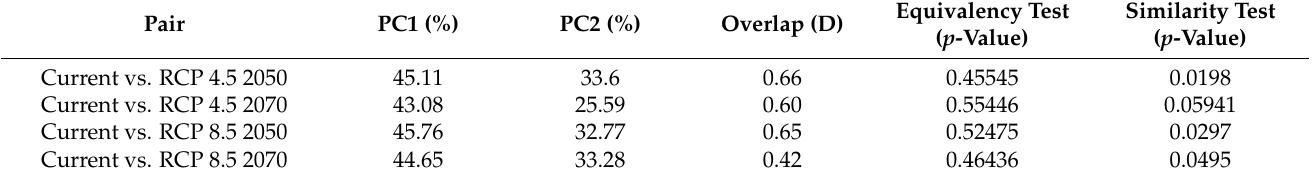
Table 6. Niche comparisons and first two principal components between current and future projected distribution of the Valeriana wallichii .